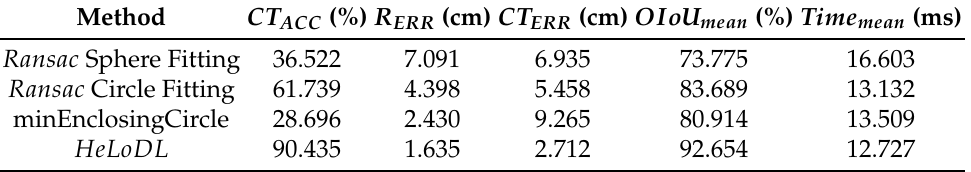
Figure 11. Visualization of the prediction of different methods. The red circle represents the predicted circle, and the green circle represents the ground truth. It is worth noting that the small green circle indicates the allowable error range, and if the center of the red circle can fall inside that circle, the prediction result meets the error requirement. Table 2. Comparison with the state-of-the-art